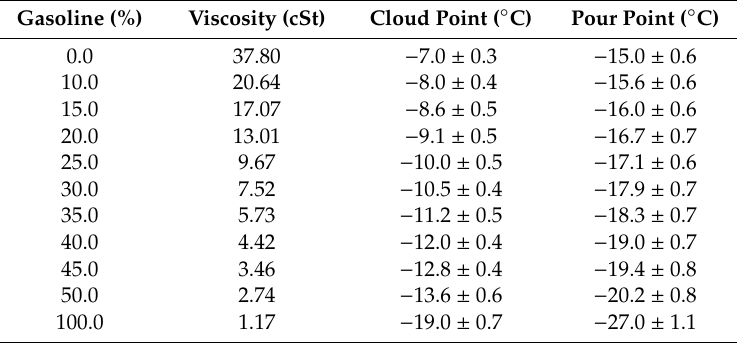
Table 1. Viscosity values at 40 °C (ASTM D2270-79), cloud point and pour point of the gasoline/sunflower oil blends. Errors are always calculated as the average of three measurements. Table1. Viscosityvaluesat40 ◦ C(ASTMD2270-79), cloudpointandpourpointofthegasoline / sunflower oil blends. Errors are always calculated as the average of three